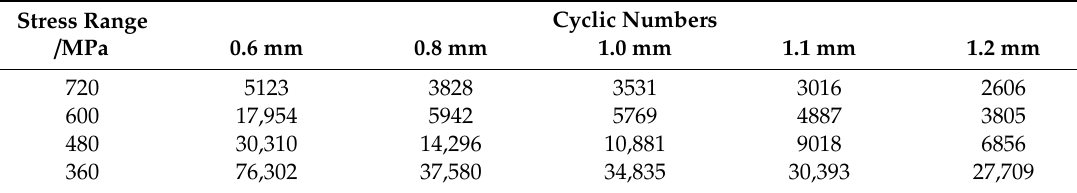
Table 5. The life of steel wire with semi-ellipsoidal notches of different depths.